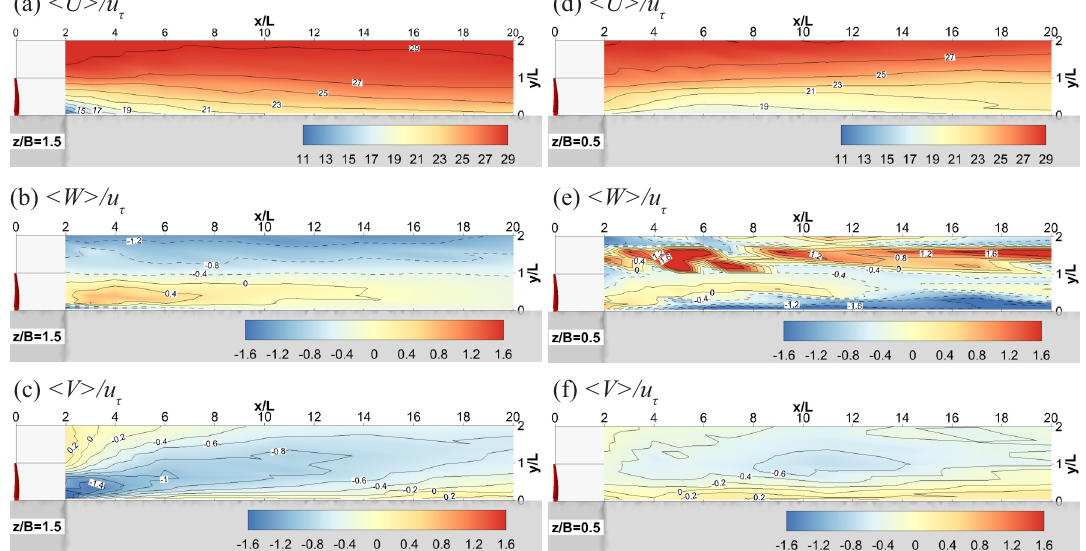
Figure 8. Dimensionless mean flow velocity contours at z / B = 1.5 (blade center height ( a – c ) and z / B = 0.5 (the midpoint between the bottom edge of the blade and the channel bed ( d – f